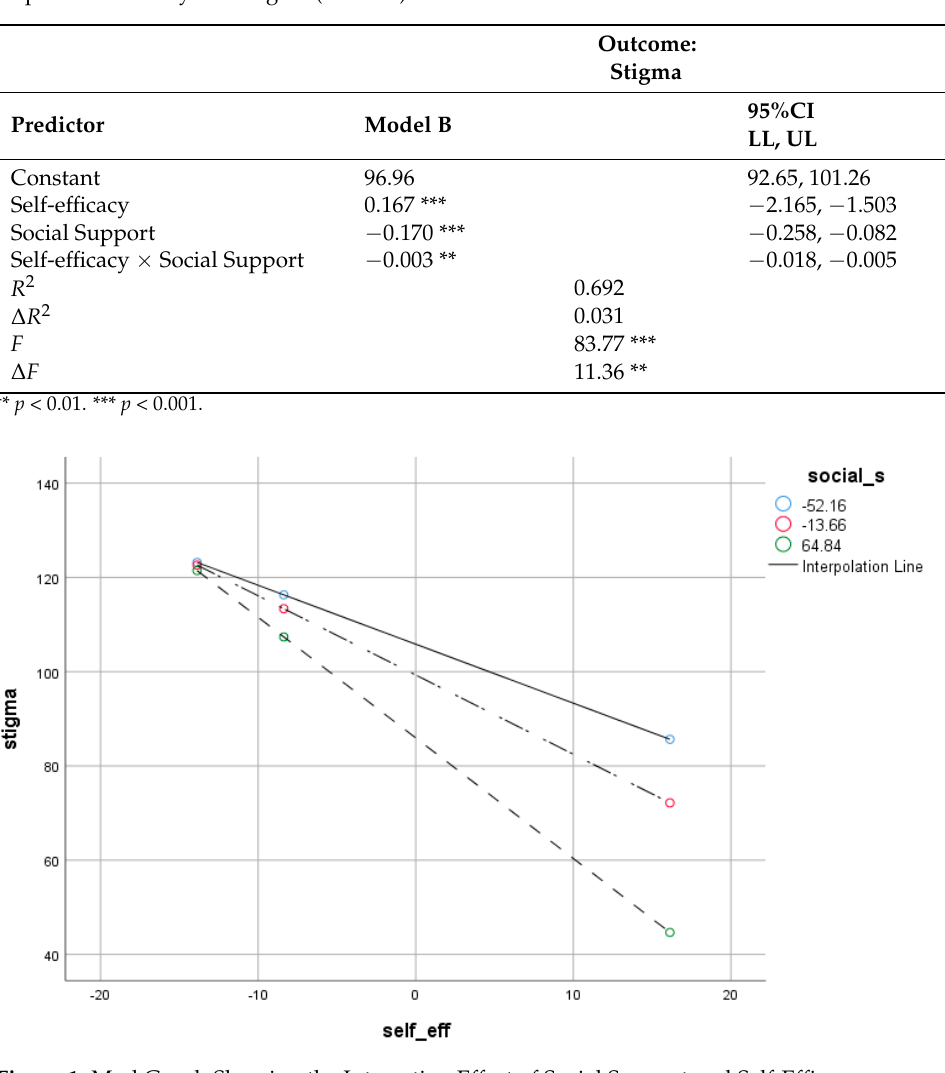
Table 4. Multiple Regression Analysis for the moderating role of Self-Efficacy within the relation- ship between Social Support and Stigma (N = 116).